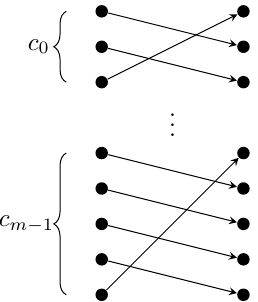
Figure 3: Permutation generated by function g